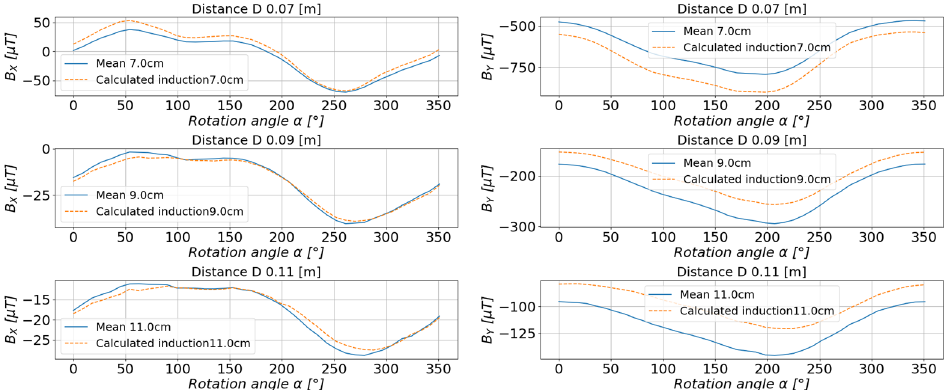
Figure 16. Comparison of the estimated values with the measured values of magnetic induction in the measurement axis X ( left ) and axis Y ( right ).